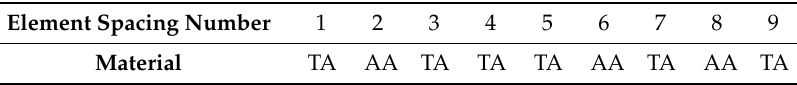
Figure 7. Nighttime light remote-sensing image.